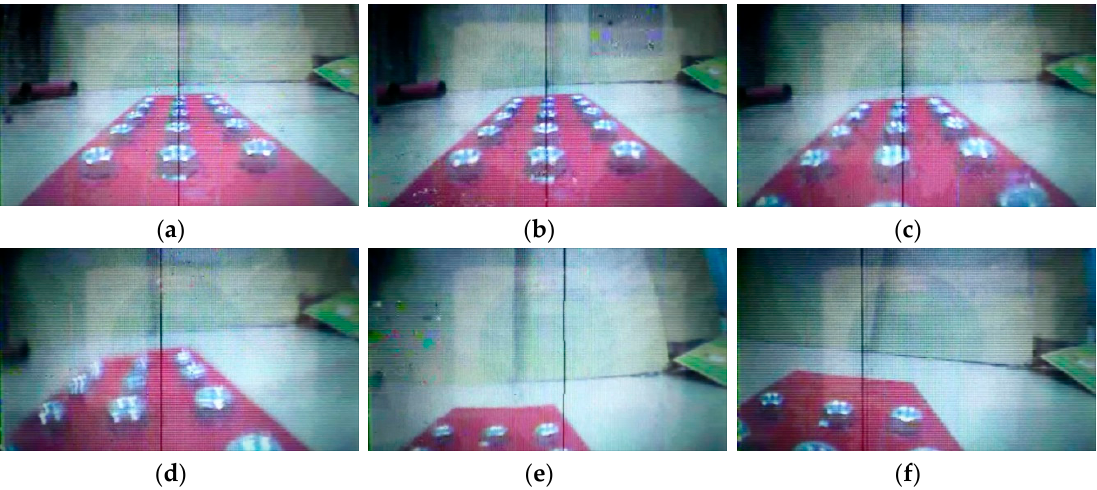
Figure 16. Images of camera attached to the front of BIREM without the control. ( a ) 0 s; ( b ) 1 s; ( c ) 2 s;